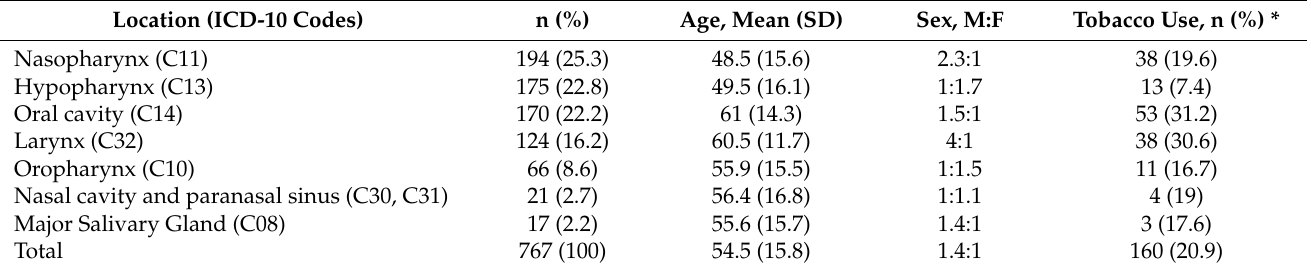
Table 2. Distribution of sites of HNCs with ICD-10 codes by age, sex, and tobacco use status, n = 767.